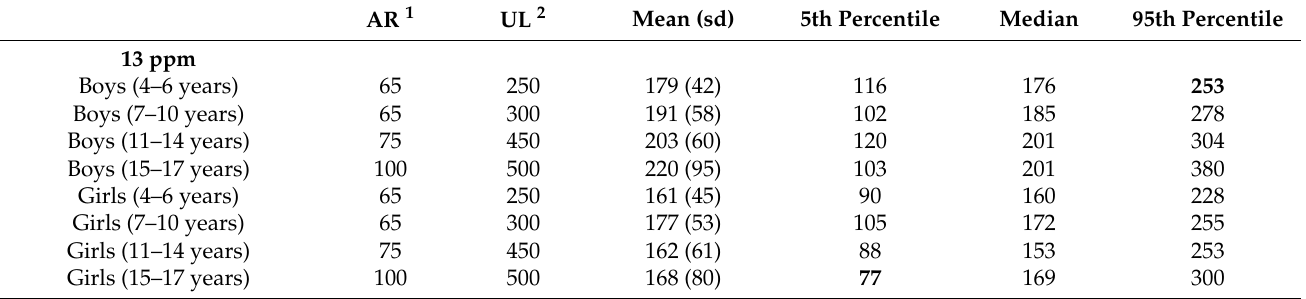
Table A1. Dietary exposure to iodine in µ g/day in Danish children aged 4–17 years at 13 and 20 ppm fortification levels based on the Danish National Survey on Diet and Physical Activity,